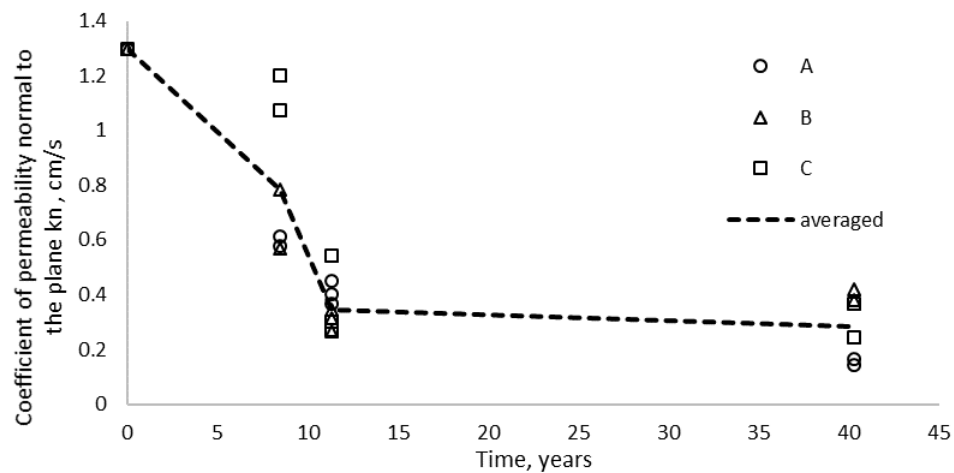
Figure 9. Changes of permeability coefficient k n over time (data after 7 and 11 years, after Reference [13]).